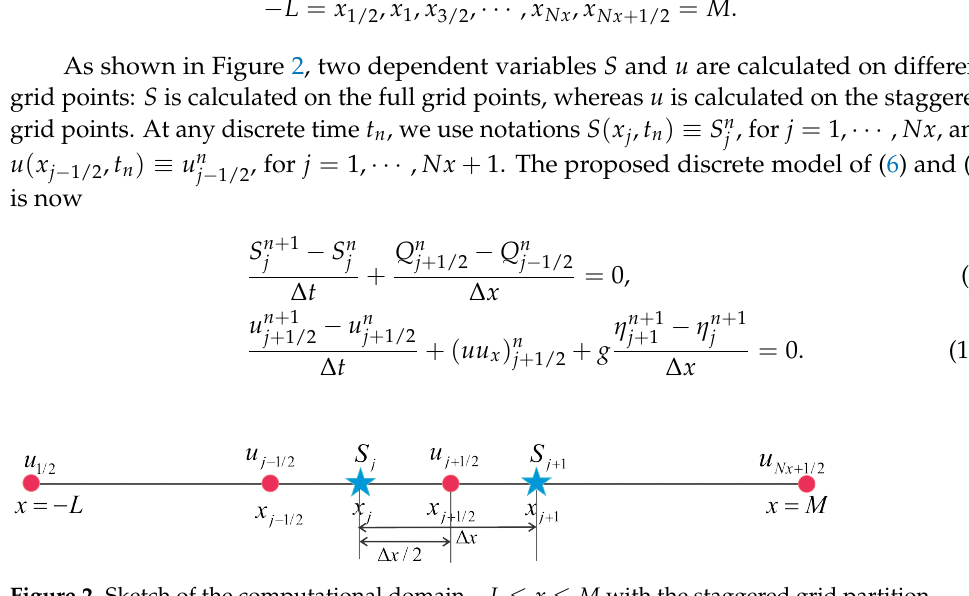
Figure 2. Sketch of the computational domain − L ≤ x ≤ M with the staggered grid